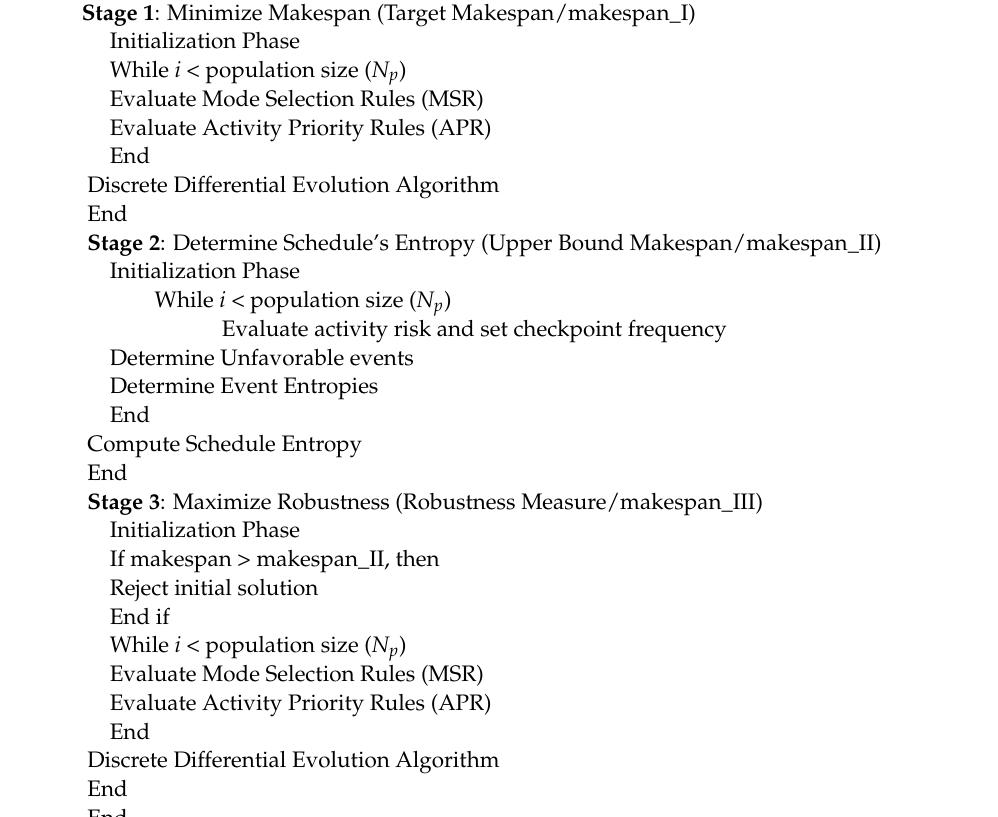
Algorithm 1: Repeat until all feasible instances are